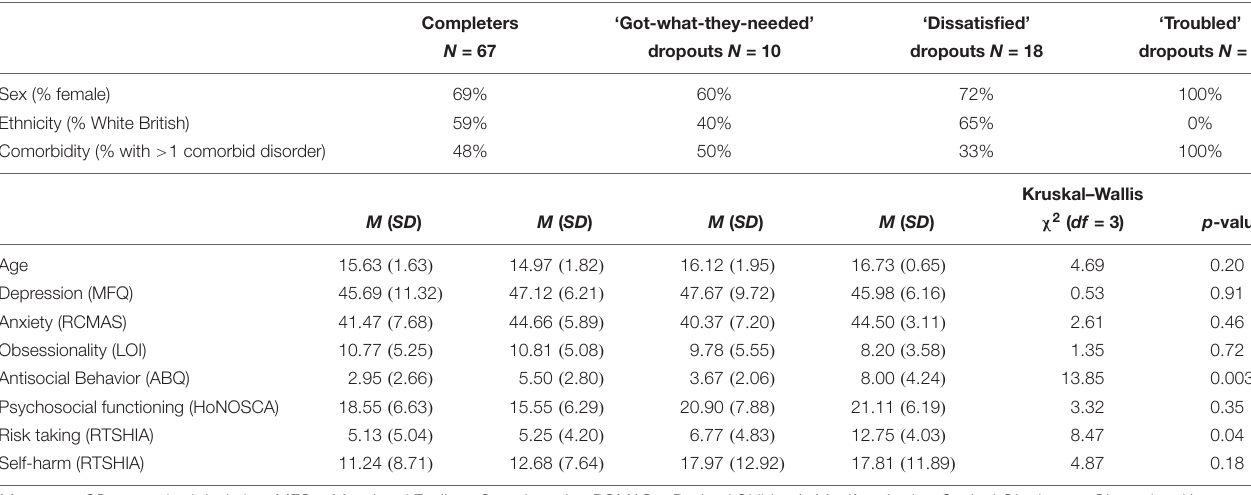
TABLE 3 | Baseline descriptive statistics for dropout types and completers.